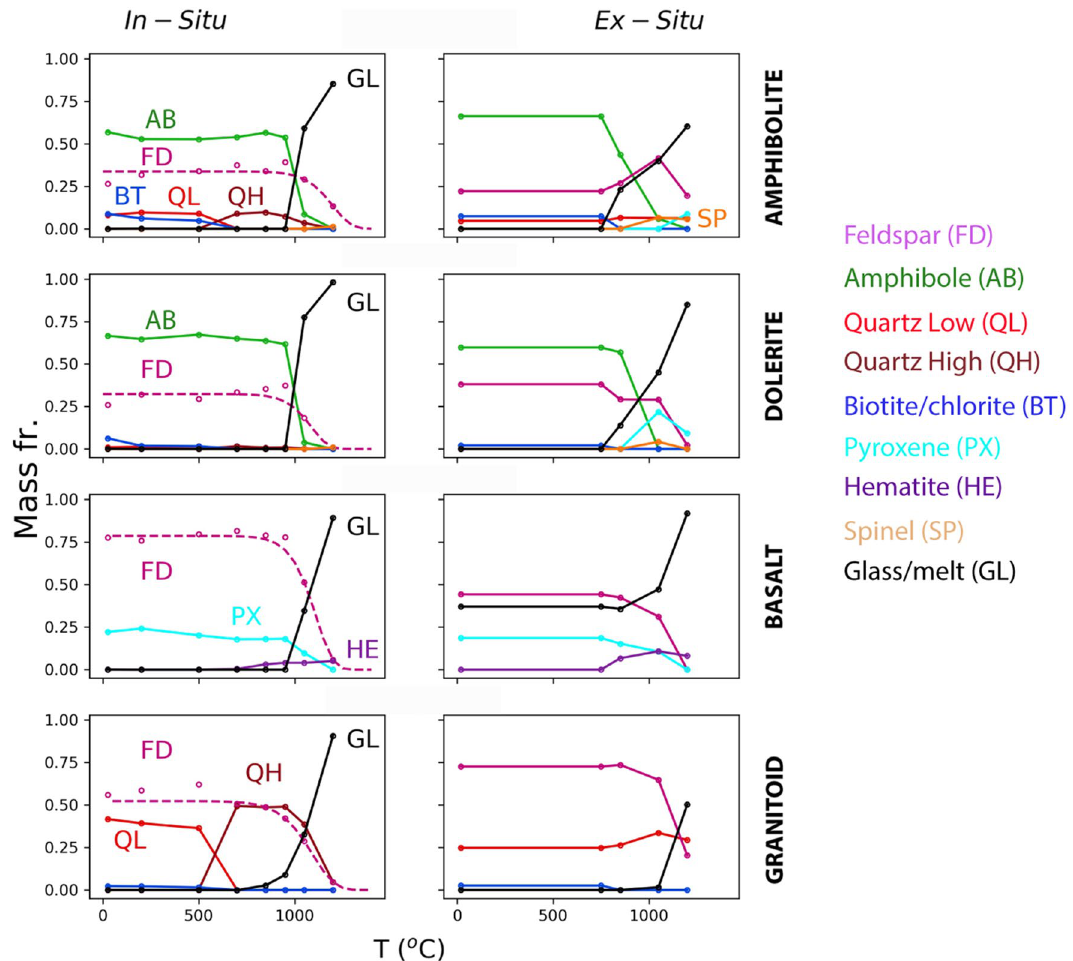
Figure 6. Phase analysis of heated rocks: amphibolite (BA5), dolerite (dike), basalt (HAS37), and granitoid (RG). Left column: In situ XRD with quantification by Rietveld refinement and calibration of the feldspar peak to determine amorphous fraction (see “Methods”). Right column: Ex situ XRD with Rietveld analysis; samples heated from room temperature to specified temperature at 10 °C min −1 as chunks in Pt crucibles, held for 15 min, then air-quenched and measured. Minerals shown: feldspar (FD), amphibole (AB), quartz low (QL), quartz high (QH), biotite + chlorite (BT), pyroxene (PX), hematite (HE), magnetite/spinel (SP), amorphous glass/melt